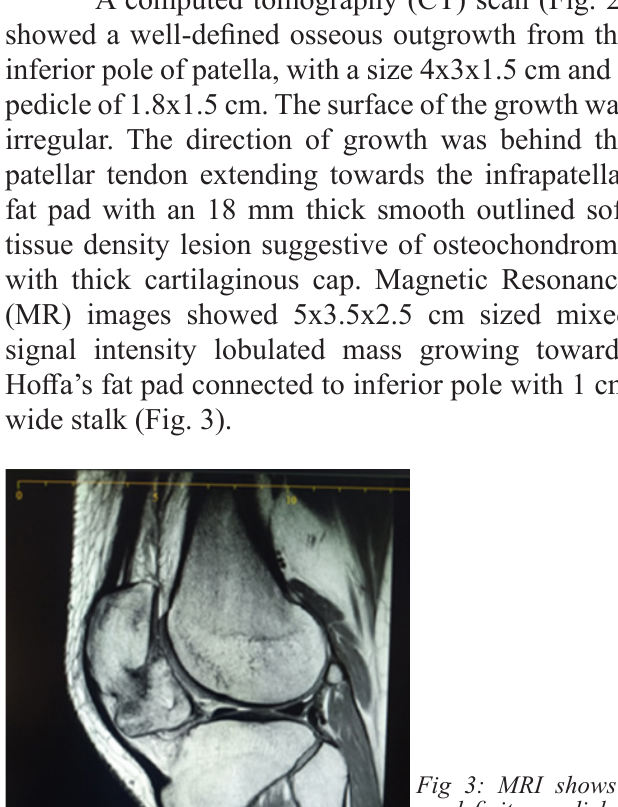
Fig 3: MRI shows a definite pedicle connecting inferior pole to the mass.